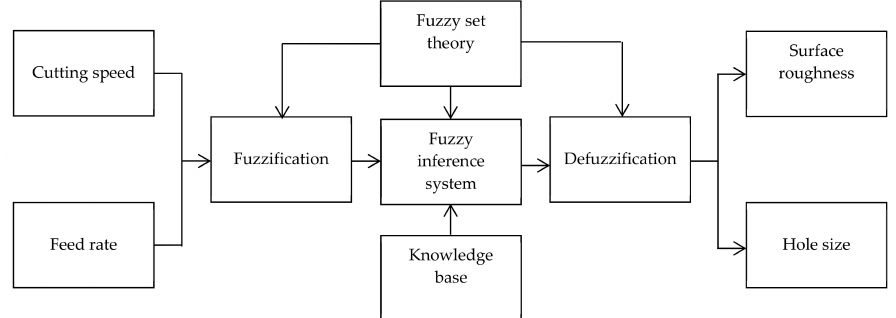
Figure 5. Schematic diagram of the developed algorithm.